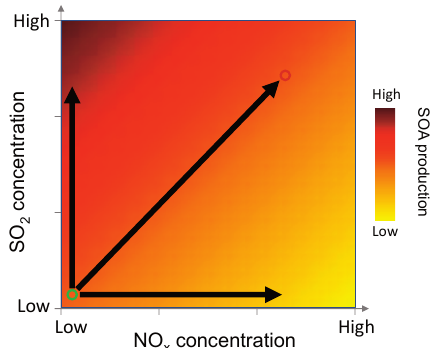
Figure 8. Conceptual schematic showing how NO x and SO 2 con- centrations affect biogenic SOA mass production. The darker colors indicate higher SOA production. The circle on the bottom left cor- ner indicates biogenic cases and the circle on the right top corner indicates the anthropogenic cases. And the horizontal and vertical arrows indicate the effect of NO x and SO 2 alone. The overall effects on SOA production depend on specific NO x , SO 2 concentrations, and VOC concentrations and